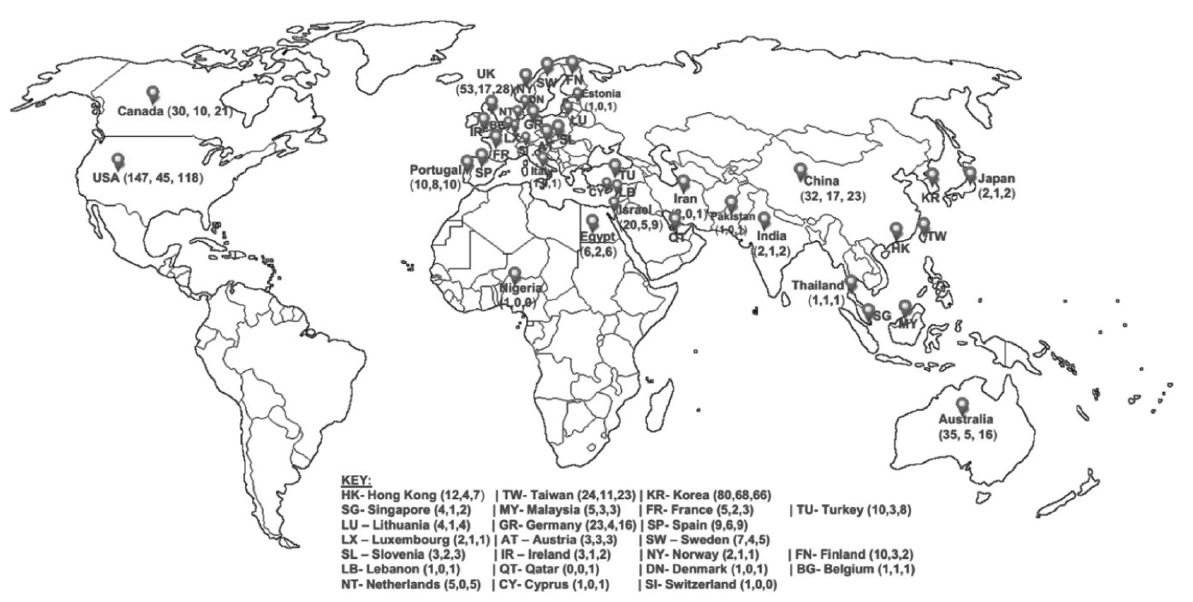
Fig. 3 . Map network visualization analysis (funding structure)